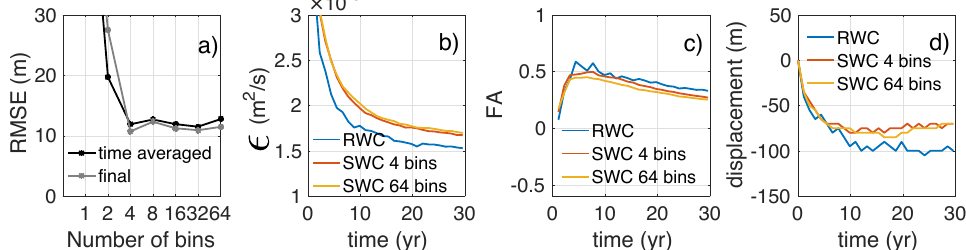
Figure 4. Time-averaged shoreline RMSE in the first 30 years and the final 5 years (Years 25–30) for SWCs with a different number of directional sectors ( a ); and the time evolution of the diffusivity ( b ), feeding asymmetry ( c ), and alongshore displacement ( d ) for the RWC and SWCs with 4 or 64 sectors.